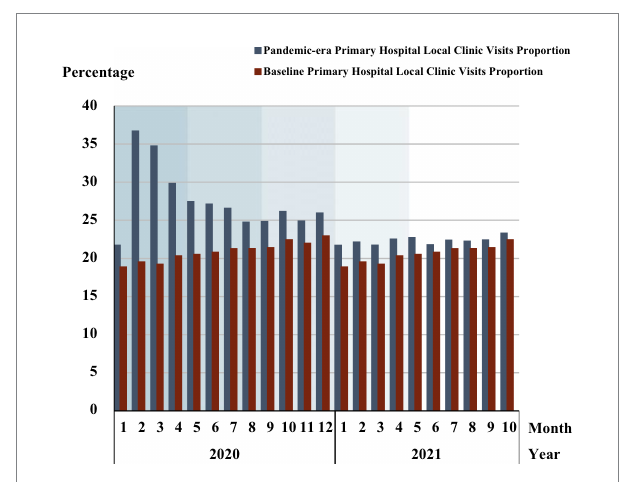
FIGURE 6 The proportion of outpatients in primary hospitals. Each shadow area denotes COVID-19 phase 1 to phase 5.